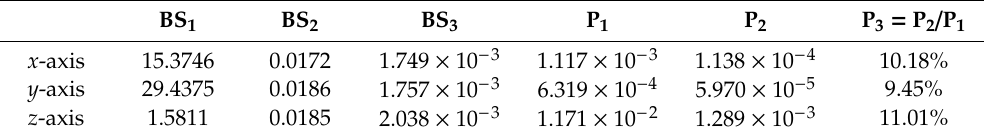
Table 7. Bias stabilities of the experimental data in 5th